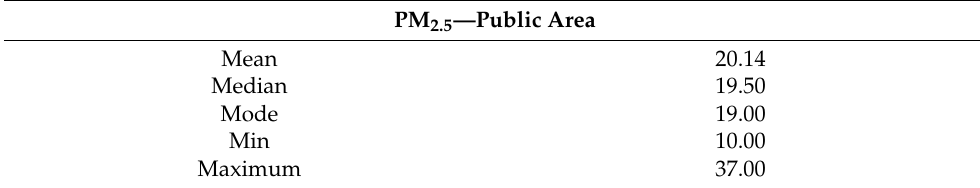
Table 4. Correlation coefficient (r) between PM 2.5 and workers in Point A and B of the construction area.